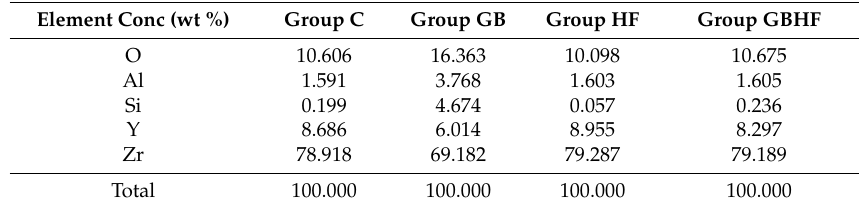
Table 2. Elemental composition of zirconia surfaces after different surface treatments by EDX.